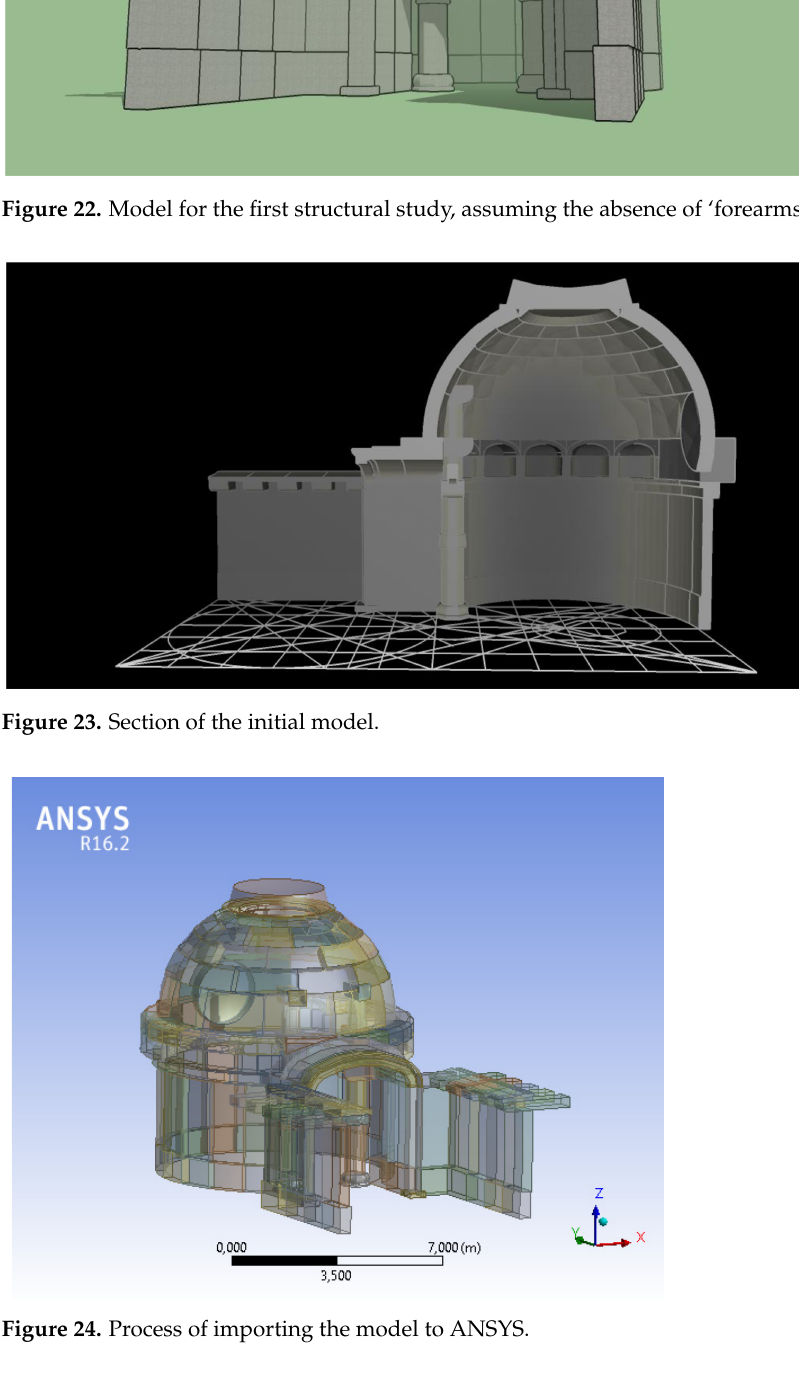
Figure 25. First test of meshing the structure. Source:.